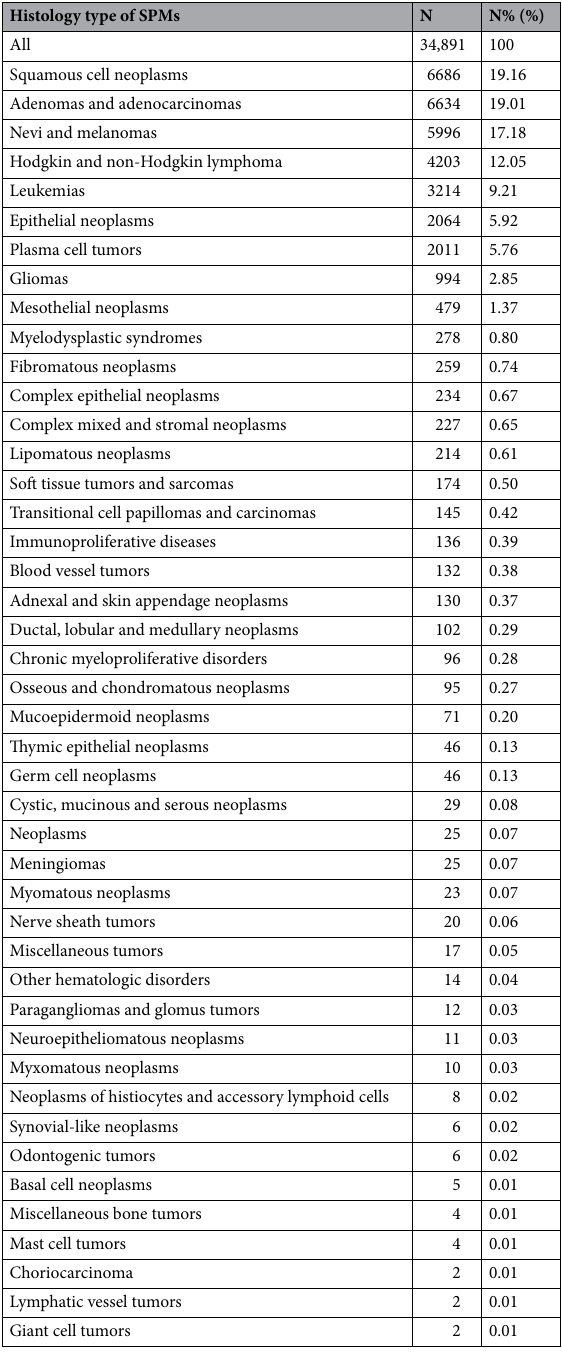
Table 2. Histology types of SPMs after PCa. Abbreviations: SPMs: second primary malignancies; PCa: prostate